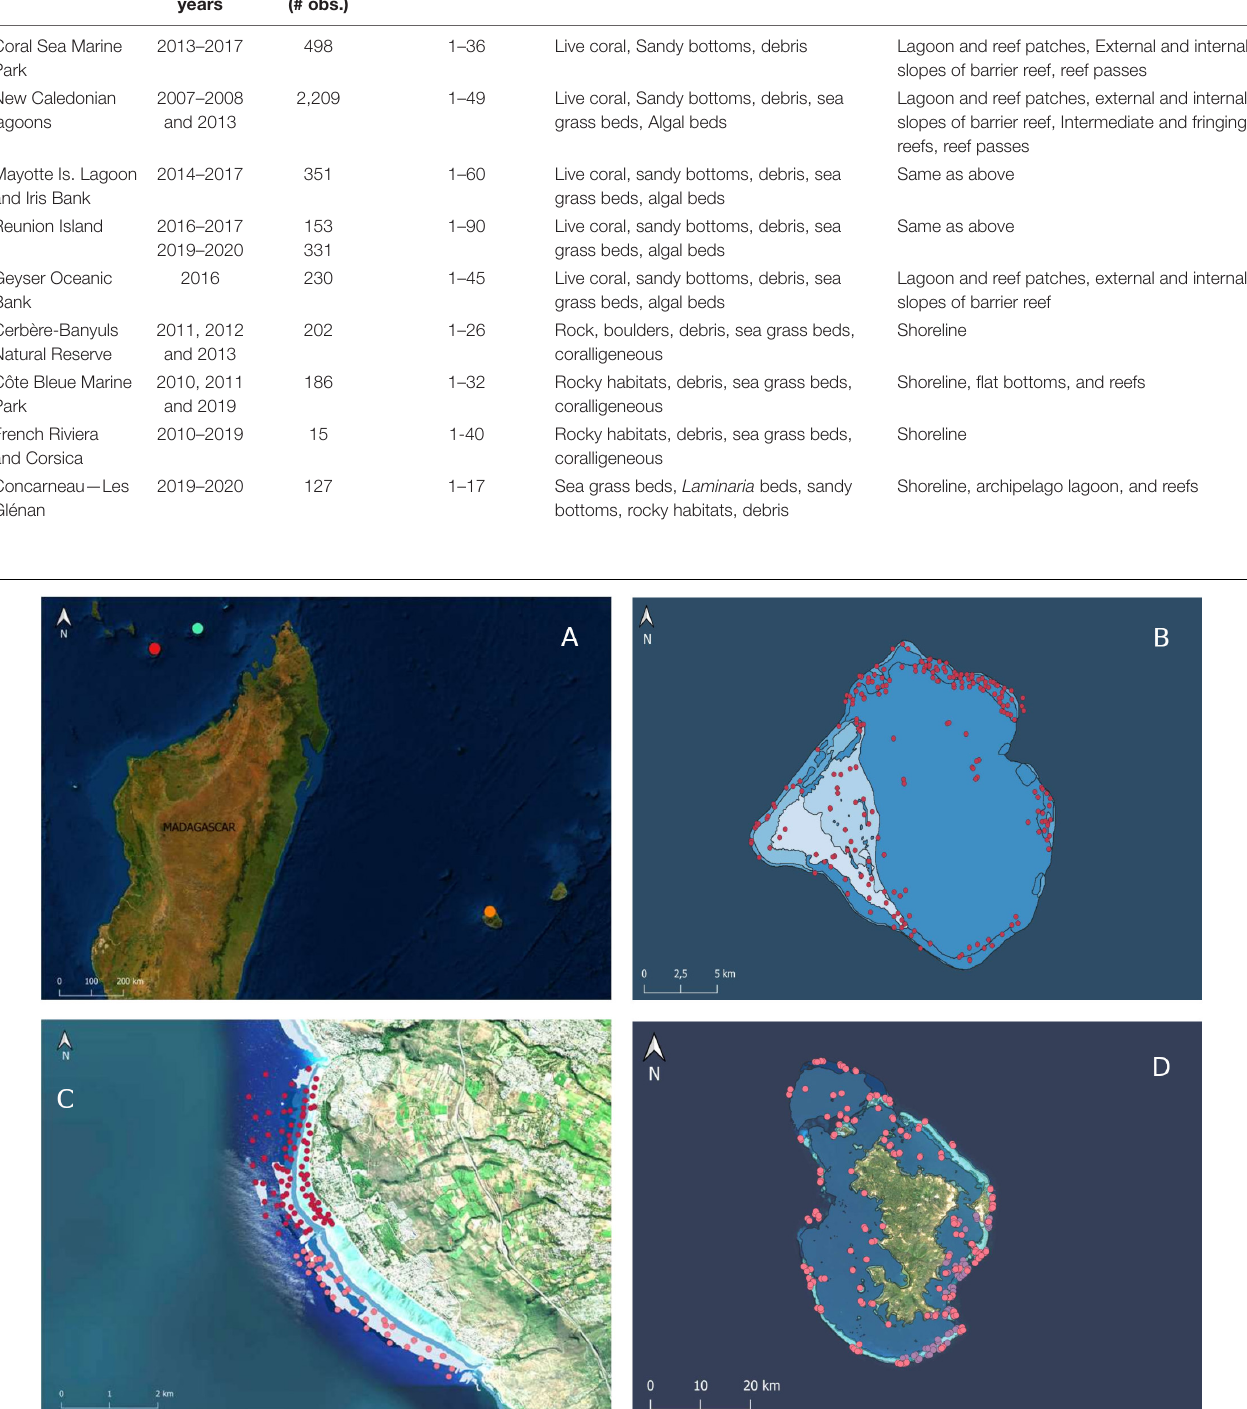
Frontiers in Marine Science |